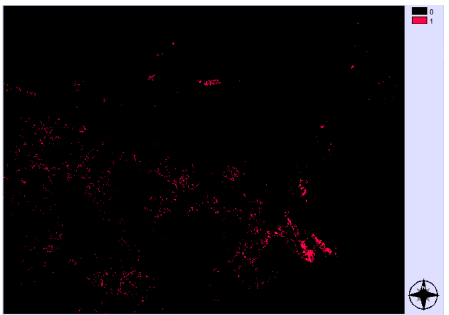
Figure 12 .Map of the probability of reducing agricultural land for the future from comparison of prediction map